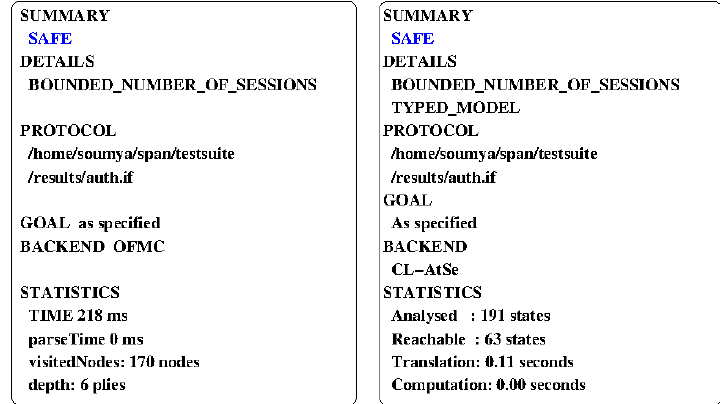
Figure 4. The simulation results under OFMC & CL-AtSe